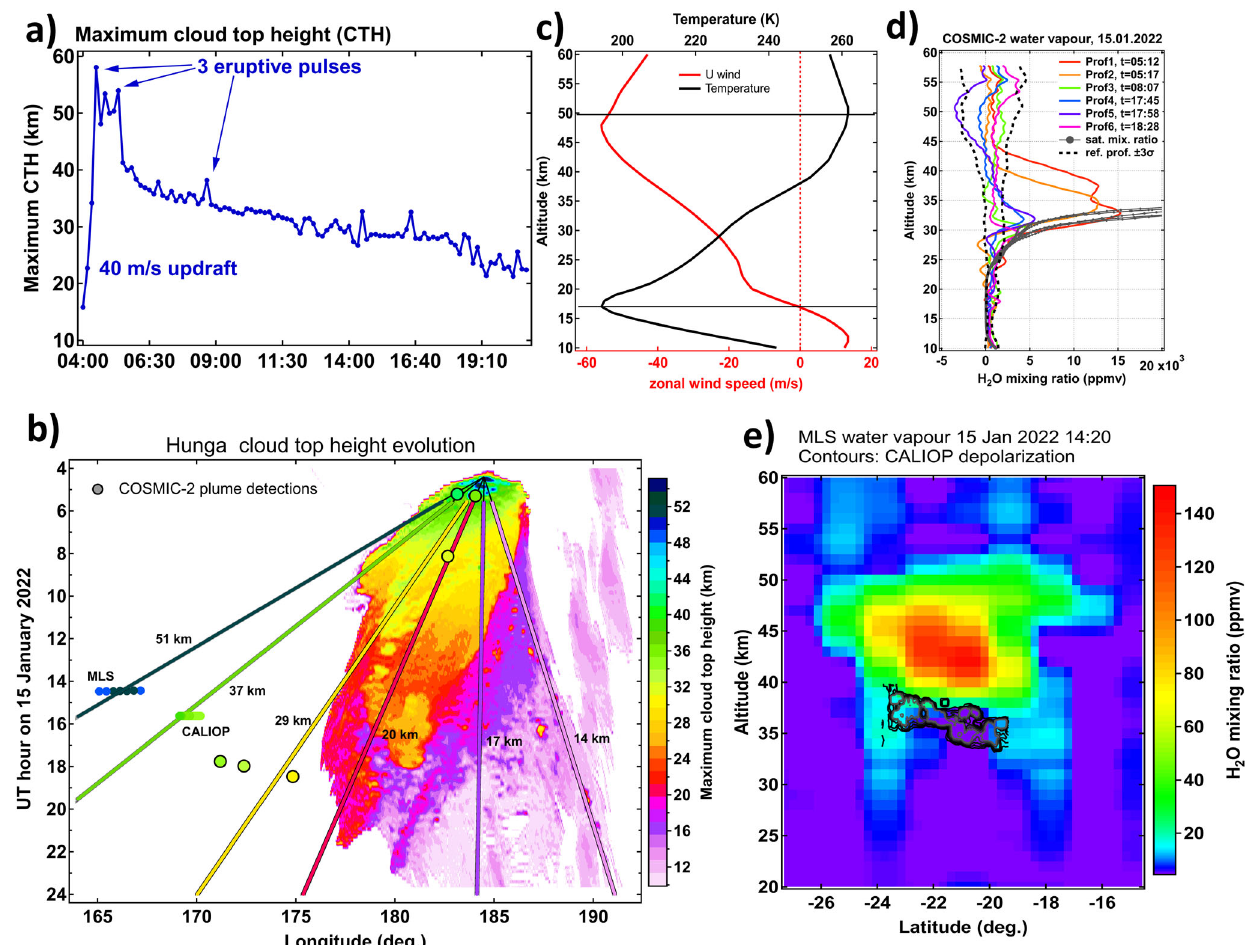
Fig. 1 Evolution of Hunga volcanic cloud top height (CTH) on the day of eruption (15 January 2022). a CTH time evolution from stereoscopic retrieval using Himawary-8 and GOES-17 geostationary imagers. b Hovmoller diagram of the maximum CTH (note the inverted time axis). Superimposed lines are color-coded by altitude and represent linear trajectories released from the volcano location at different heights indicated in the panel. The circles color-coded by altitude indicate the detections of water vapour and aerosol plumes respectively by MLS and CALIOP (see panel e ). The black-encountered circles indicate the detection of hydrated layers by COSMIC-2 (see panel d ). Note the color correspondence between the trajectories and downwind detections of the plume con fi rming the CTH retrieval. c Temperature and zonal wind pro fi les averaged over 5°× 5° box centered at the volcano location from European Center of Medium-range Weather Forecasts (ECMWF). d water vapour pro fi les inside the volcanic plume (locations shown in panel b ) retrieved from COSMIC-2 radio occultations (using ECMWF temperature) and the corresponding saturation mixing ratio pro fi les (black dashed lines) from ECMWF analysis. The dashed black curves provide an approximate range of uncertainty from the median of the retrievals ±3 standard deviations on the day before the eruption (January 14). e Latitude-altitude cross section of water vapour from MLS (color map) and depolarization ratio from CALIOP (contours, fi rst contour is 0.05, interval is 0.05, last contour is 0.25). The time and longitude of MLS and CALIOP plume measurements are given in panel b